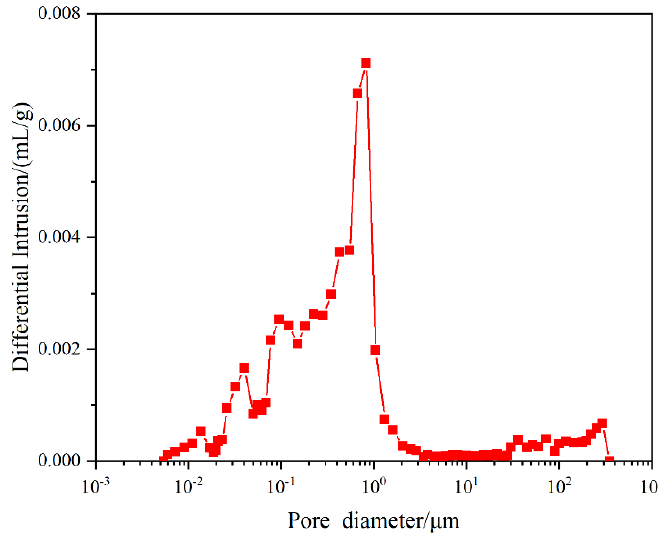
Figure 2. Distribution characteristic of core pore.